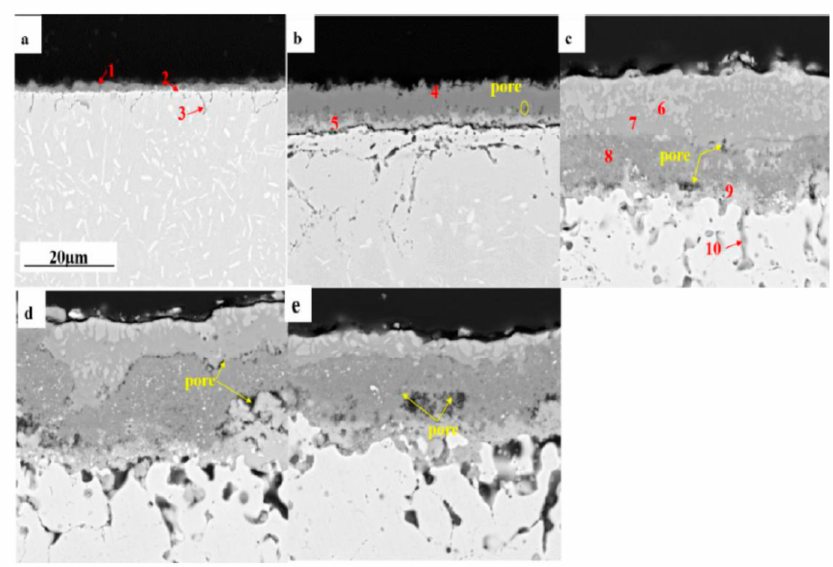
Figure 6. SEM cross-section morphologies (SEM, BEI) of corrosion products formed after ( a ) No. 0.5